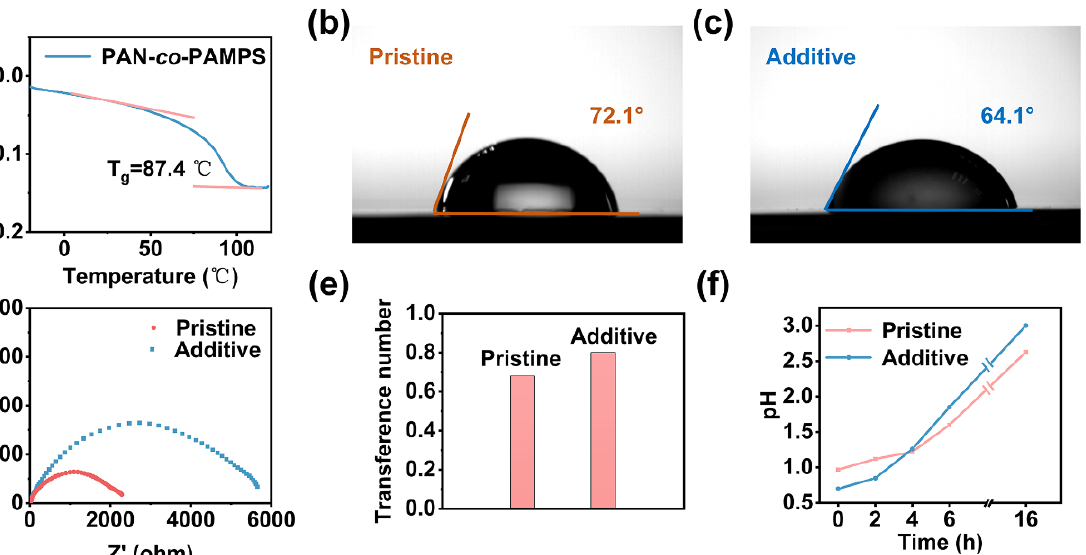
Figure 1. Schematic illustration of the Zn-stabilizing mechanism of PAN- co -PAMPS. Molecule distribution at the surface of Zn anode of Zn|Zn symmetric cell using ( a ) pristine and ( b ) additive- containing electrolyte.